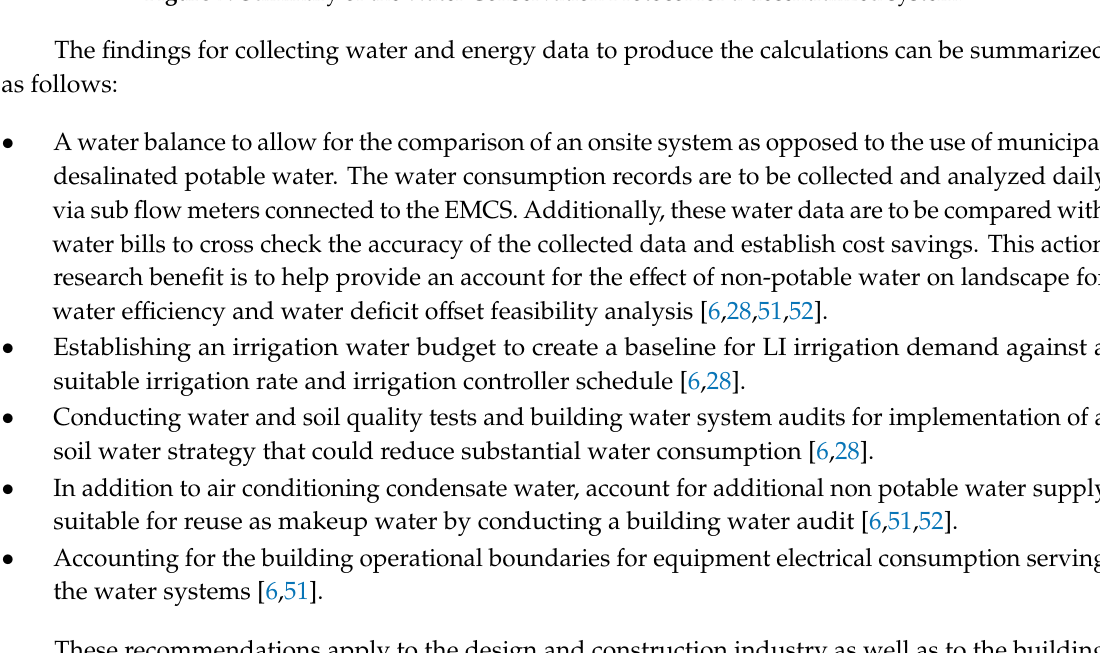
Figure 7. Summary of the Water Conservation Protocol for a decentralized system.